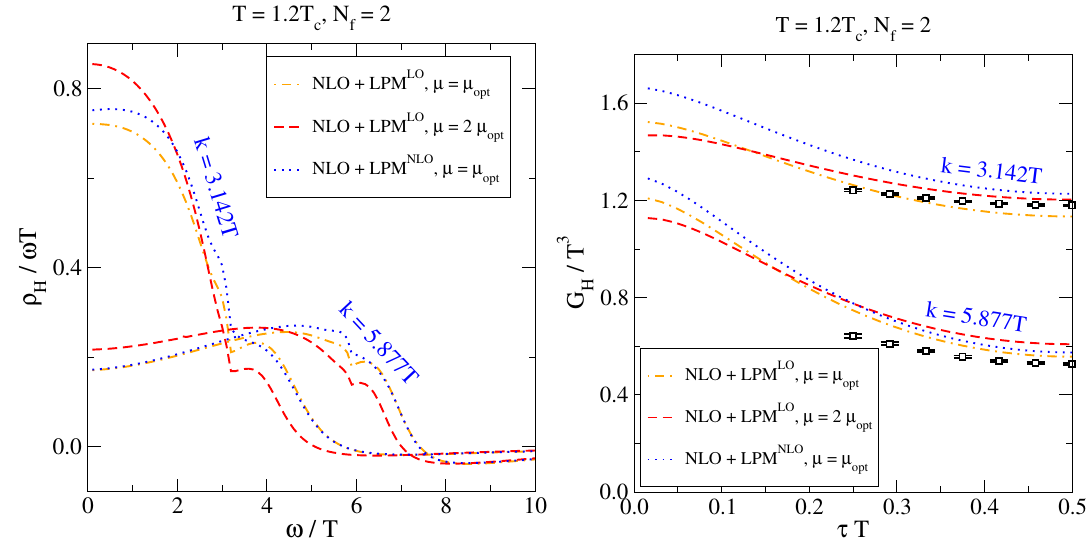
Figure 3 . Results for (cid:26) (left) and G (right) at T ’ 1 : 2 T for N = 2. The black squares are c f H H lattice data from refs. [35, 53], multiplied by a factor 2 (cid:31)=T 2 , where (cid:31) (cid:25) 0 : 88 T 2 [53], in order to convert to our units. The notations LPM LO and LPM NLO and the scale choices are as in (cid:12)gure